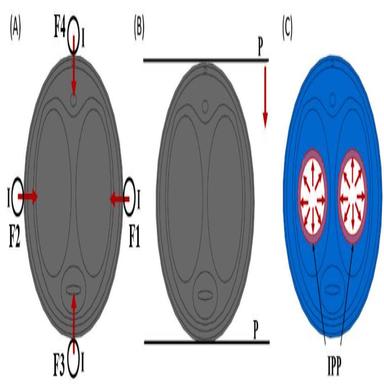
Finite element model of (A) Indenter test, (B) Plate compression test, and (C) IPP implantation.